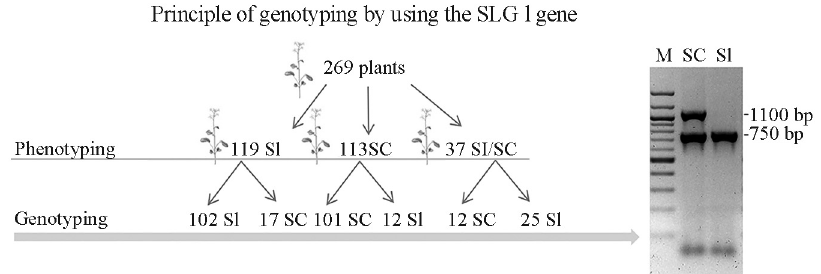
Figure 2 - Phenotypic and genotypic screening of F 2 DH plants. The plants (n = 269) initially underwent S phenotypic analysis followed by genotyping with molecular markers. Duplex PCR with class I SLG-specific primers (SLGa forward and reverse) resulted in the amplification of an ~1.1 kb fragment in plants considered to be self-compatible (SC); self-incompatible (SI) plants showed no such fragment. All samples (SC and SI) showed amplification of a 750-bp internal control fragment. M – molecular